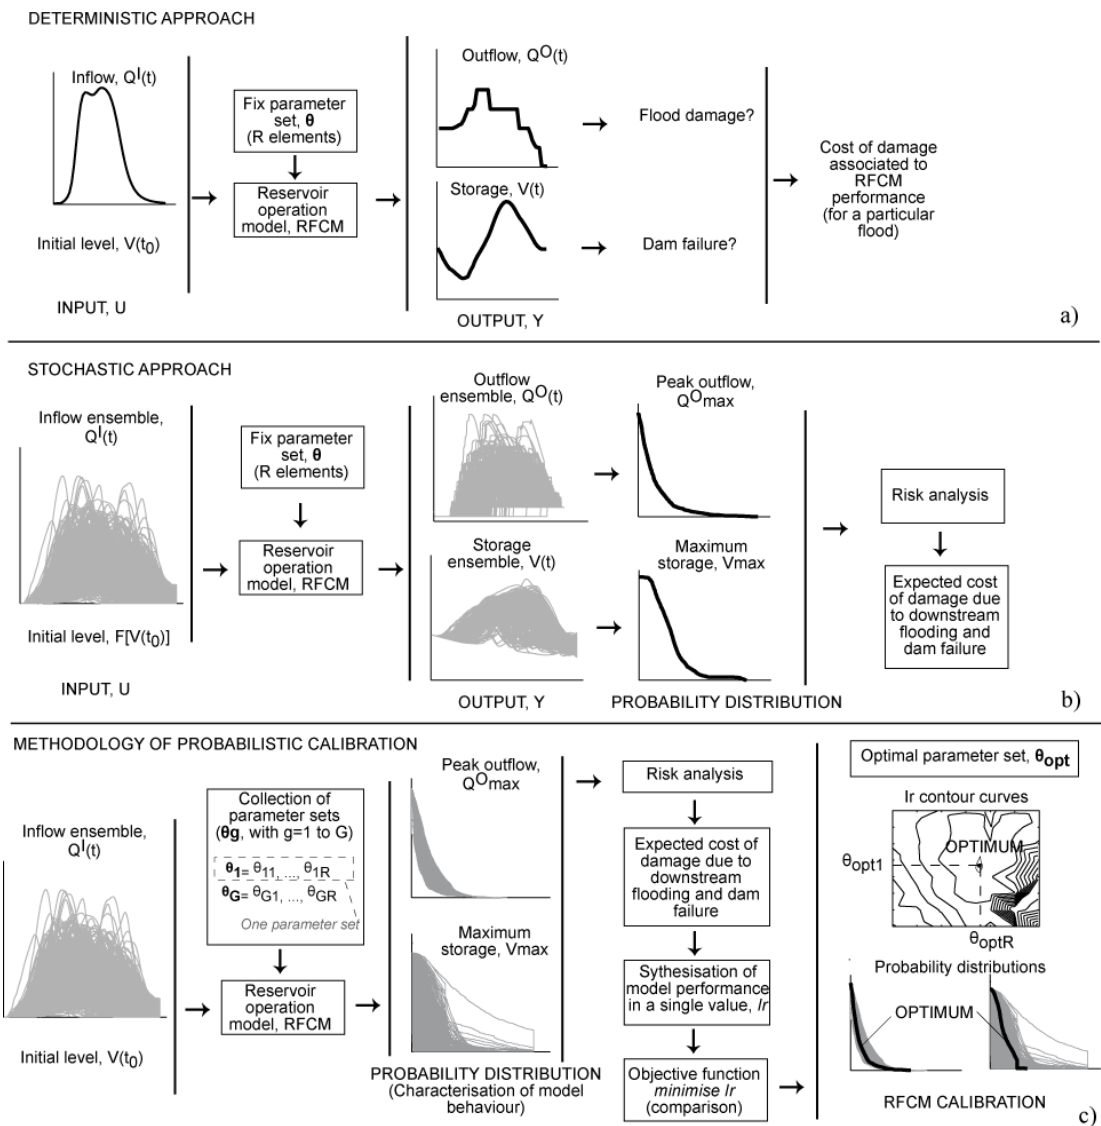
Fig. 1. Conceptual framework and methodological